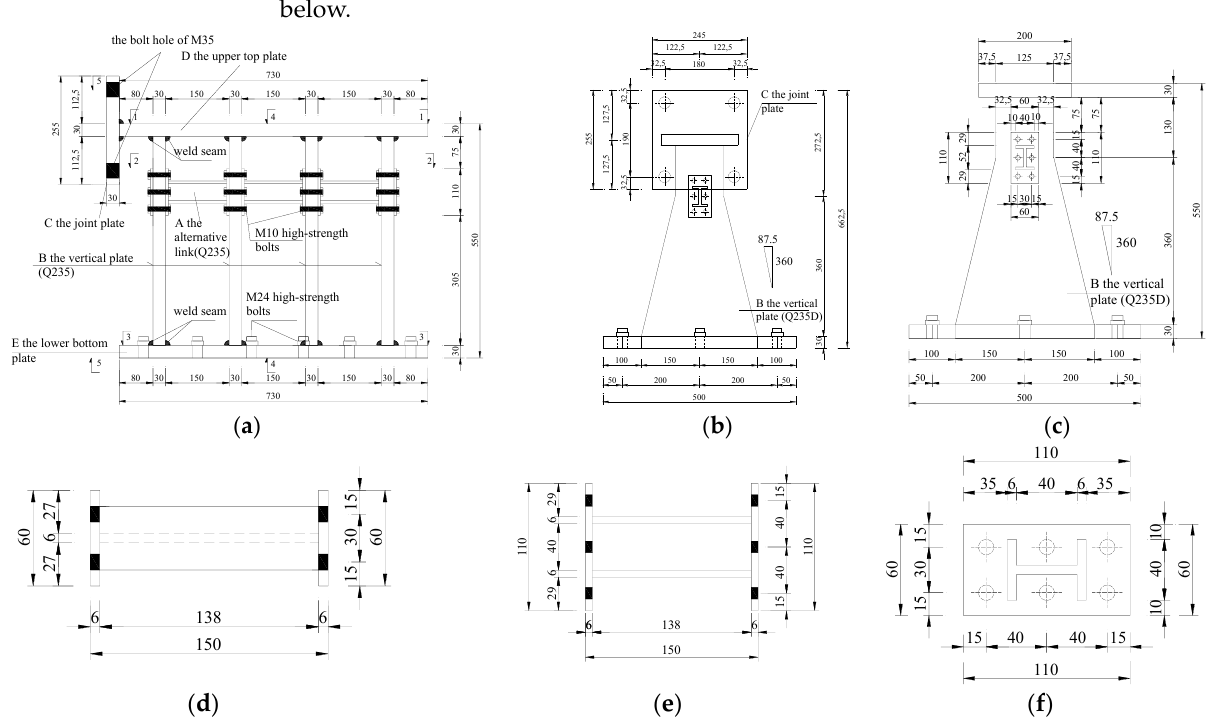
Figure 4. Specimen size drawing. ( a ) Standard specimen elevation; ( b ) standard specimen vertical plate; ( c ) standard specimen loading end-plate; ( d ) the alternative link plan view; ( e ) the alternative link elevation view; ( f ) the alternative link side view.